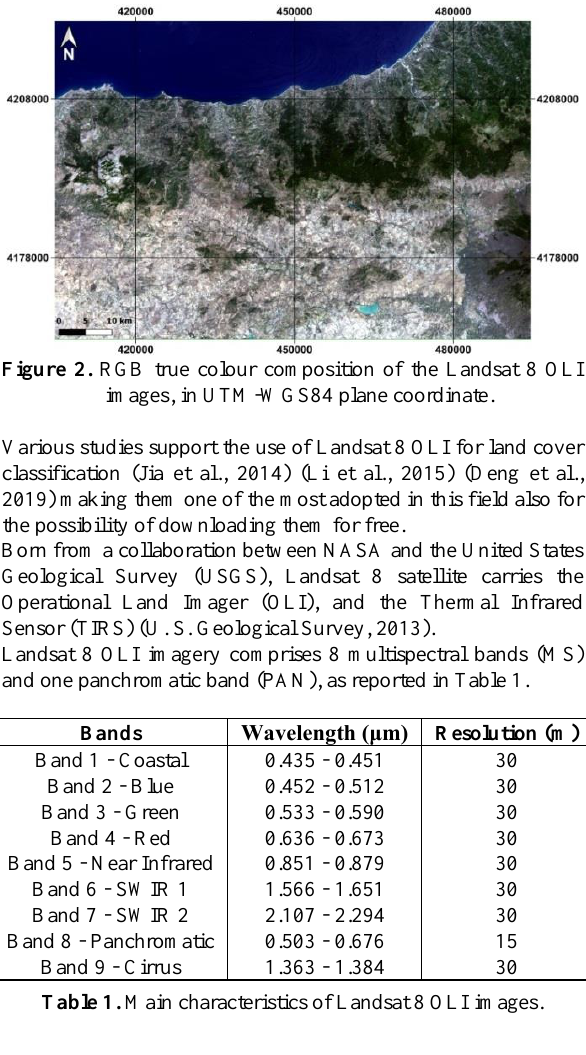
Figure 2, in RGB true colour composition of the Landsat 8 OLI imagery used for this article.